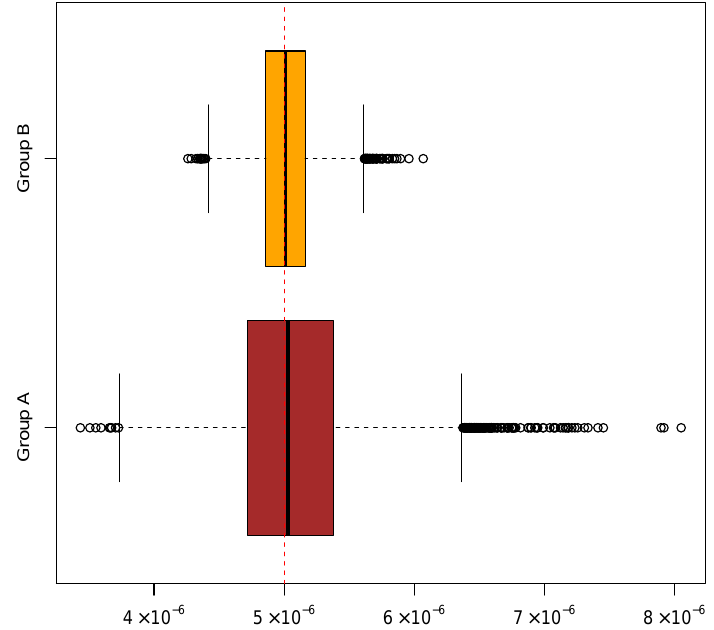
Figure 2. Distributional patterns of maximum likelihood estimates of mutation rates based on two groups of simulated experiments. Each group comprises 10,000 experiments simulated by assuming a common mutation rate of 5 × 10 − 6 .